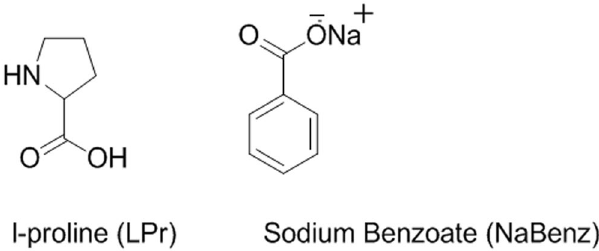
Figure 1. Molecular structure of studied